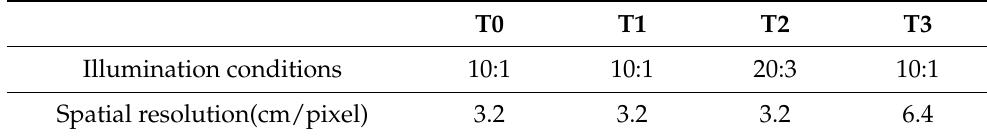
Table 1. Simulation data